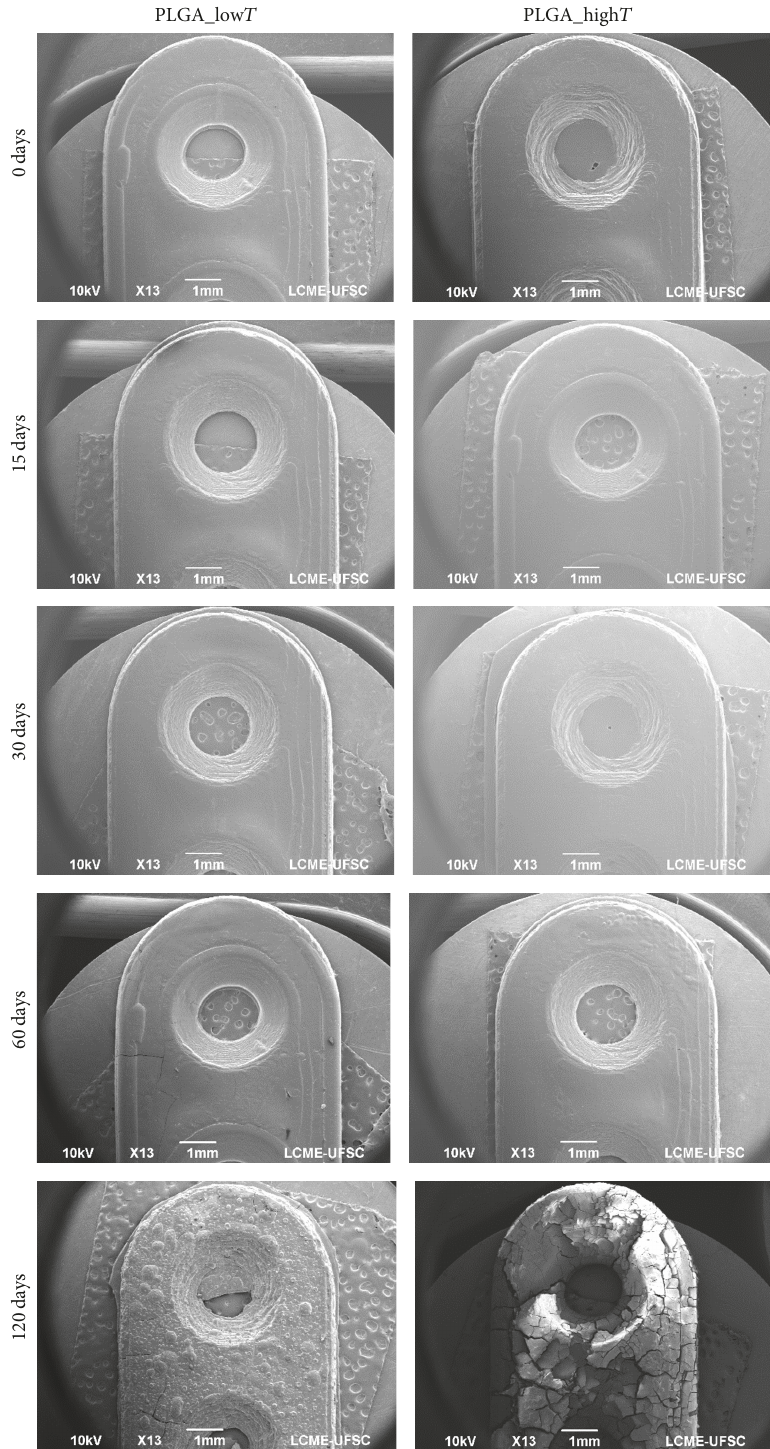
Figure 6: SEM images of the PLGA low T and PLGA high T plates at different degradation time (0, 15, 30, 60, and 120 days) (bar scale =